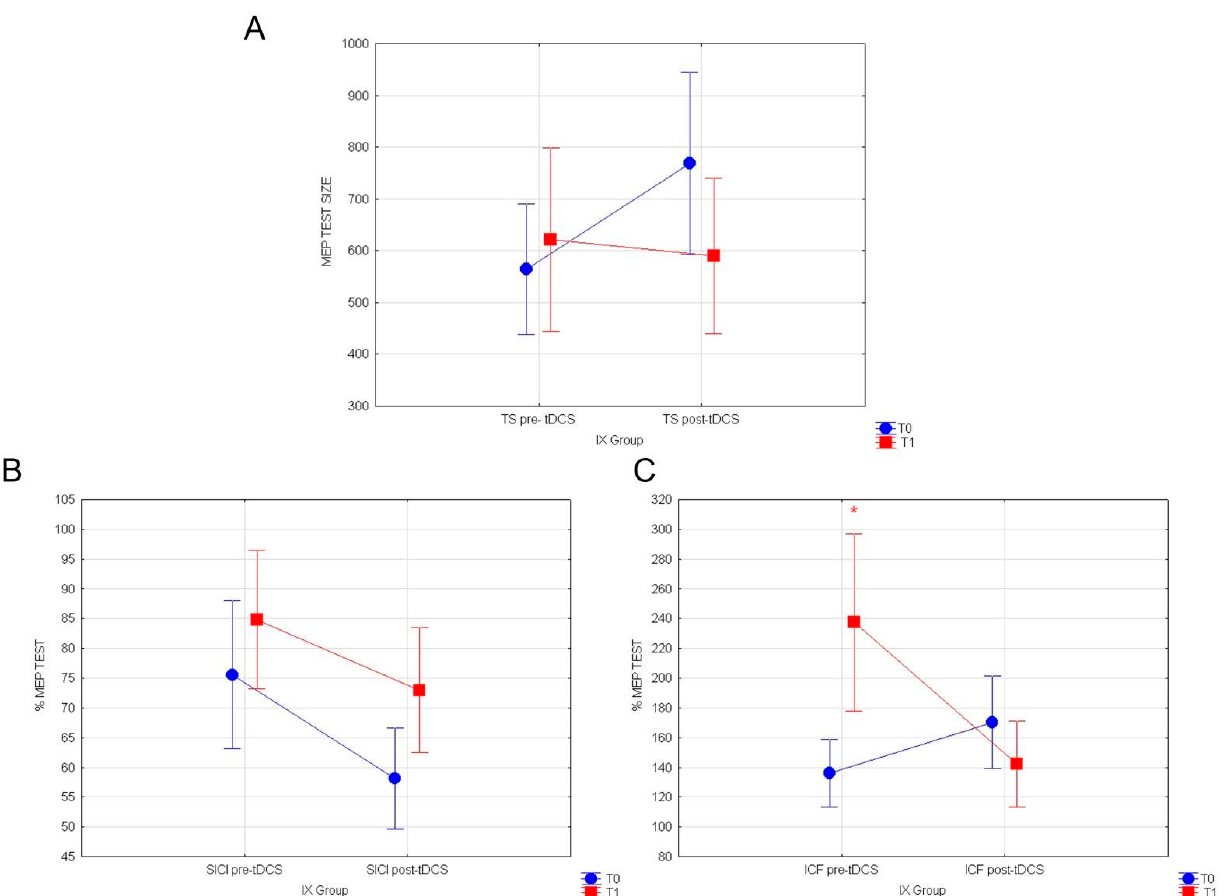
Figure 4. ( A ) MEP values for TEST stimulus, ( B ) normalized % MEP for SICI, and ( C ) normalized % MEP for ICF, at T0 vs. T1 for the IX group, are shown in pre vs. post-TDCS. Vertical bars denote 0.95 confidence intervals. (*) for p <